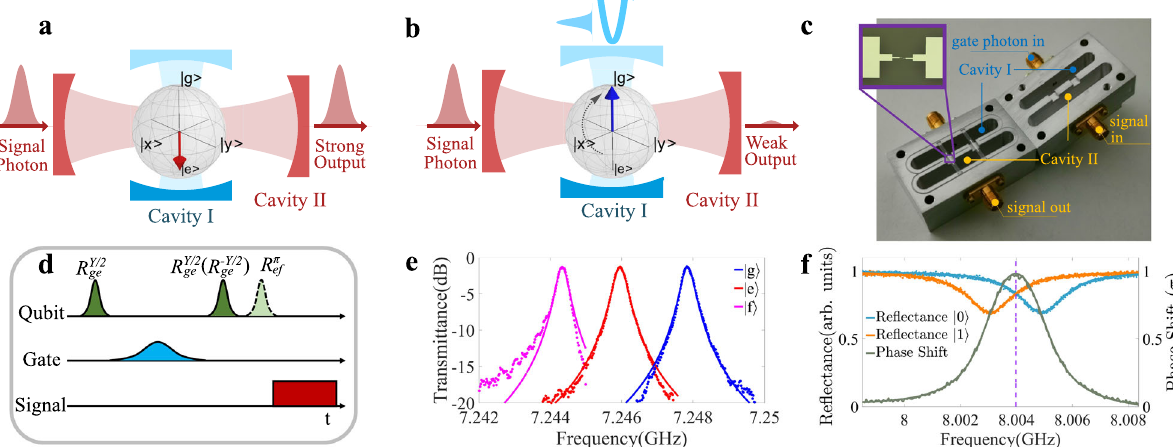
Fig. 1 | A single-photon transistor. Our microwave single-photon transistor con- sists of a superconducting qubit dispersively coupled with two superconducting cavities. Cavity I is used to couple the gate photon with the qubit which in turn controlsthetransmissionofsignalphotonsthroughCavityII. a Whenthegatepulse contains no photon, the qubit state would be fl ipped to either ∣ e i or ∣ f frequencyofthe signalphotonsisresonantwiththedispersivelyshiftedfrequency of cavity II, most of the signal photons would pass through the cavity, and the transistor is"on''. b When the gate pulse contains a singlephoton, the qubitwould (cid:1) stay at ∣ g after the pulse sequence. The signal photons are off-resonant with the frequency of cavity II, and thus few signal photons can pass through the cavity. Consequently, the transistor is switched "off'' by the single gate photon. c shows a